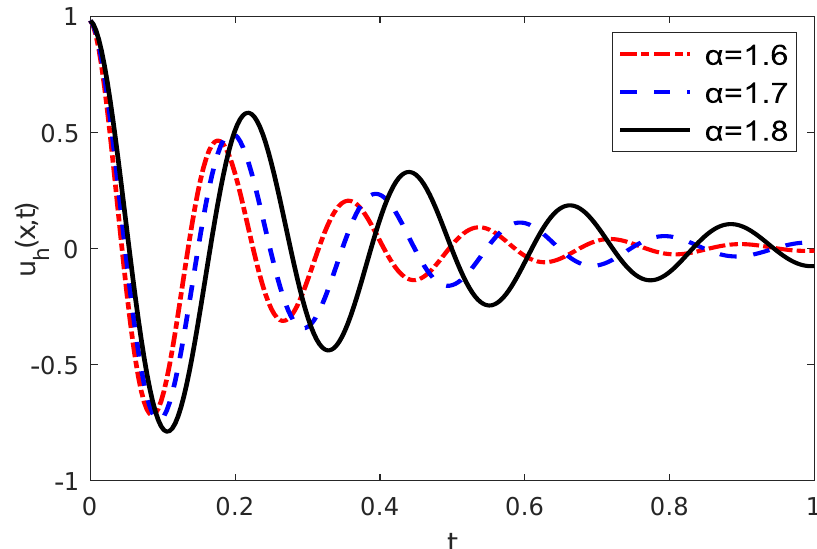
Figure 8. Graph of u h ( x , t ) at the midpoint over time for different values of α